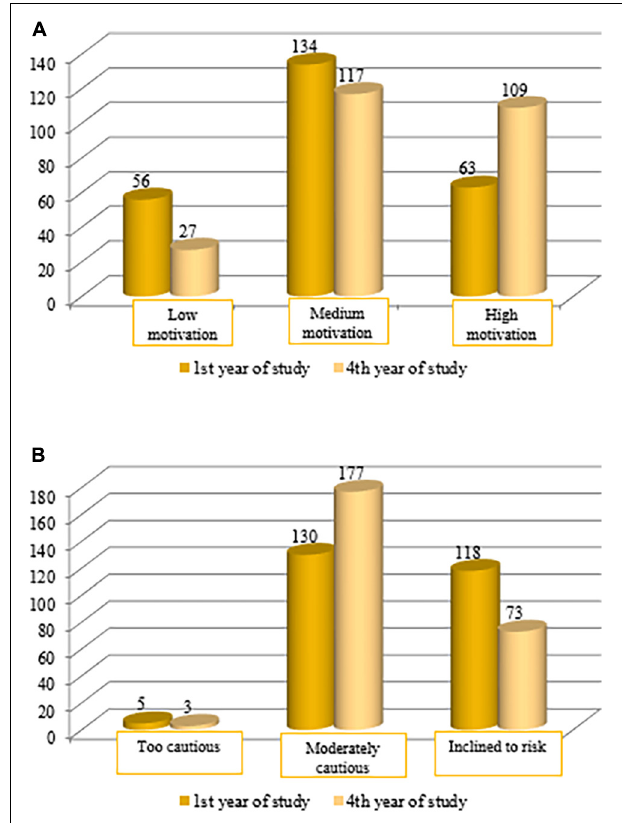
FIGURE 1 | Dynamics of the level of motivation for success (A) and propensity to take risks (B)